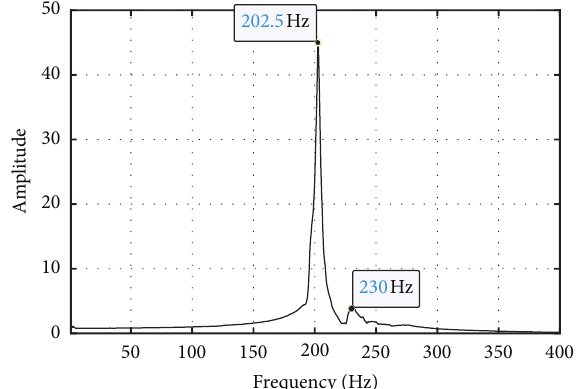
Figure 16: FTF (below 400Hz) for cargo bolts in damage case ① .